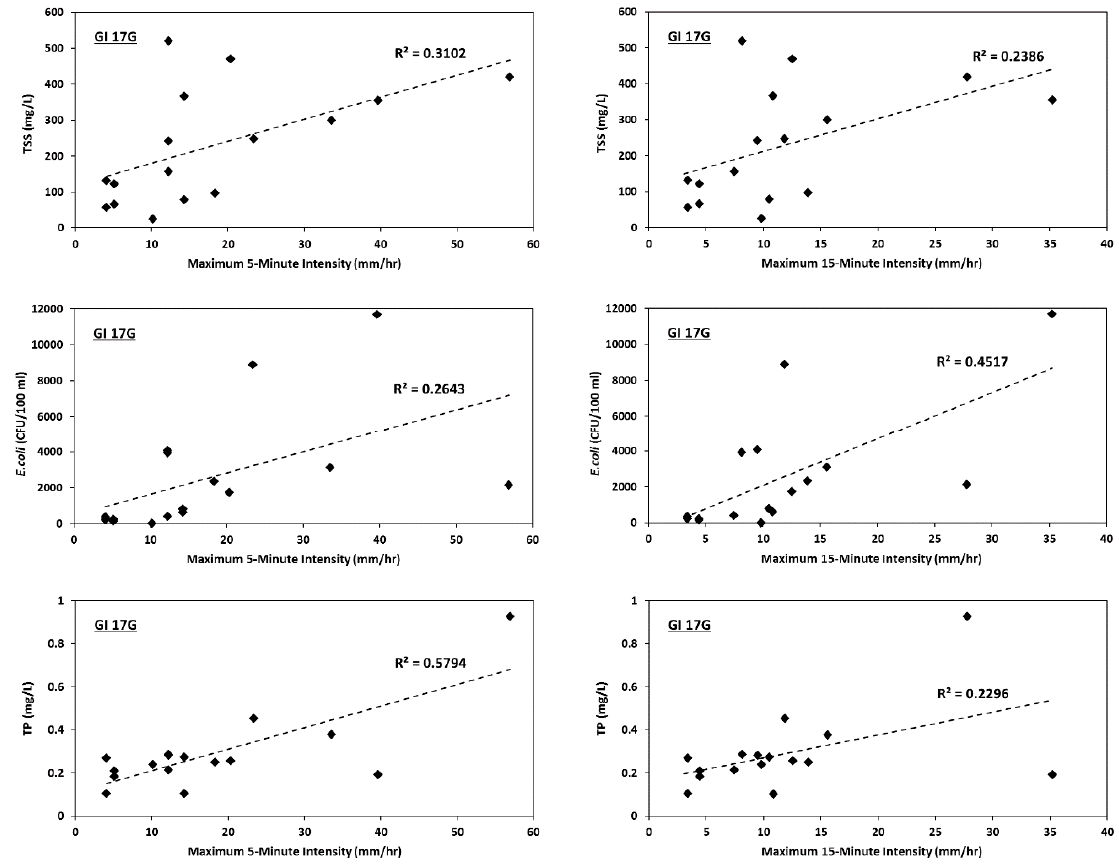
Figure 7. TSS, E. coli , and TP concentrations in the runoff versus maximum 5-min and 15-min intensity values in GI 17G.